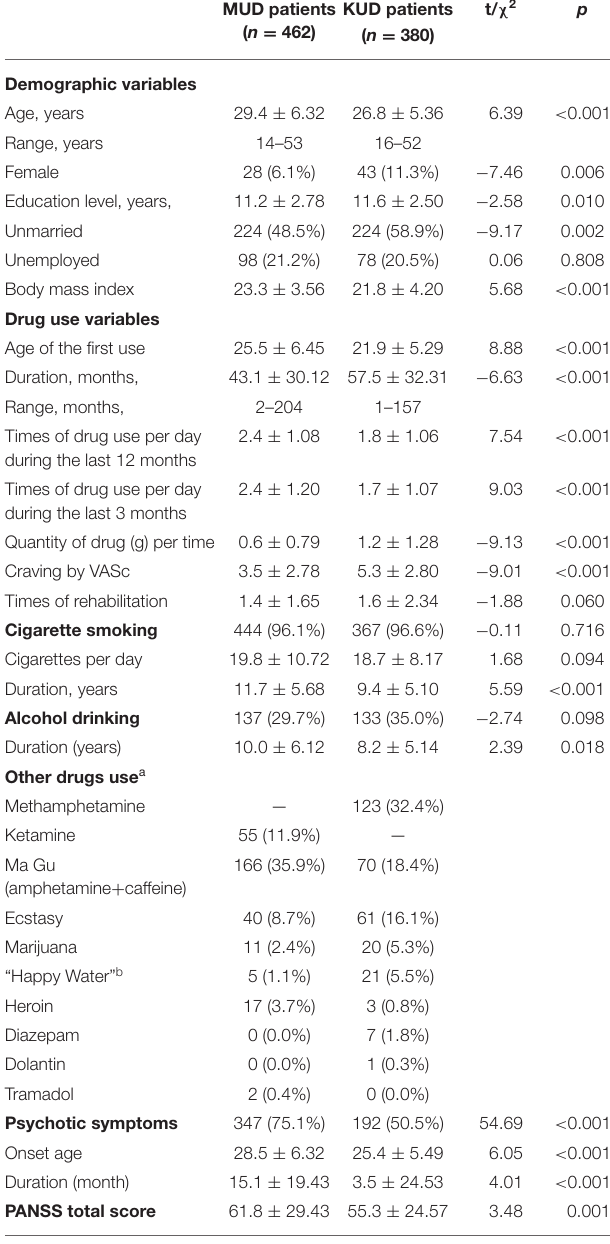
TABLE 1 | Sample characteristics.